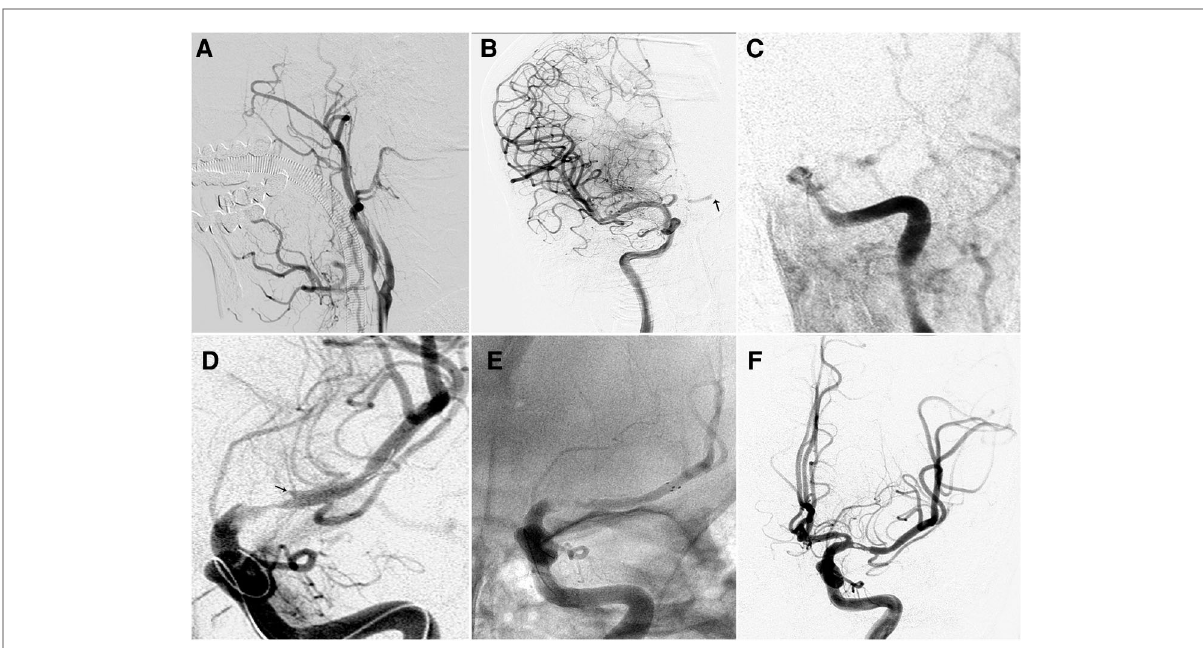
FIGURE 2 Mechanical thrombectomy for a patient with right carotid terminus occlusion and subsequent left middle cerebral artery occlusion with underlying fenestration. ( A ) Right internal carotid artery angiogram showing carotid terminus occlusion. ( B ) Control angiogram after thrombectomy showed complete reperfusion of right internal carotid artery and subsequent occlusion of left middle cerebral artery (arrow). ( C ) Left internal carotid artery angiogram con fi rmed occlusion of left middle cerebral artery. ( D ) After release of the Revive SE 4.5×22 mm, angiogram showed antegrade fl ow and the occluded segment highly mimicked atherosclerotic stenosis. Notably, there was a spike (arrow) toward the occluded segment. ( E ) After failure of fi rst pass, the Solitaire 6×30 mm was then delivered and unsheathed. ( F ) After a second pass, complete recanalization was achieved with normal antegrade fl ow and fenestration was